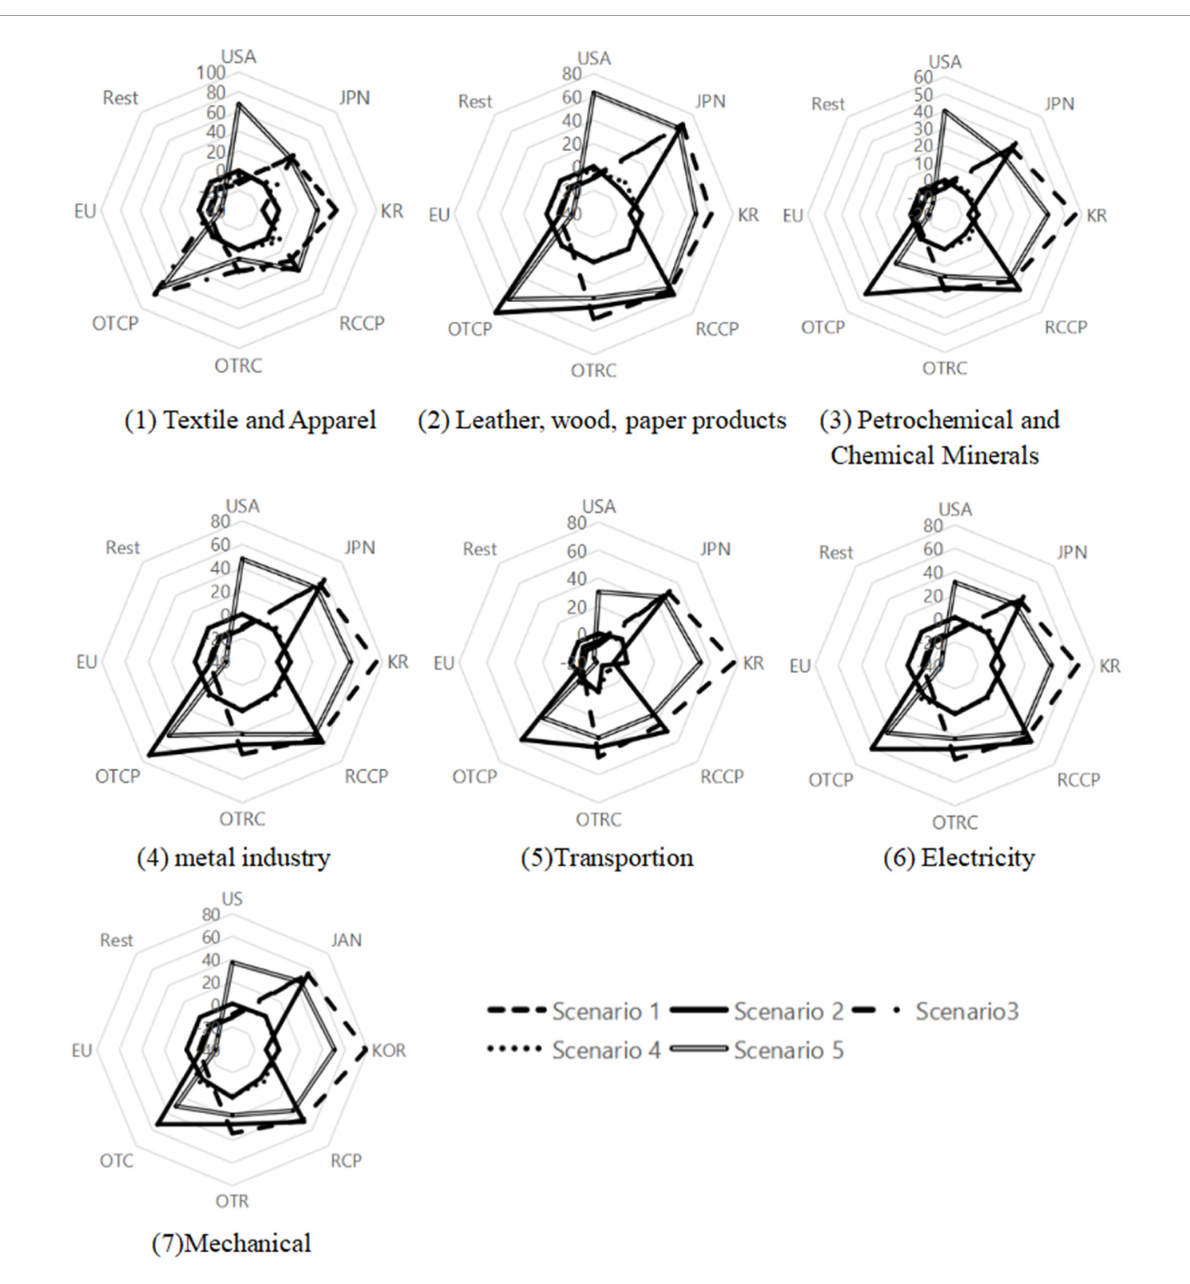
FIGURE1 Impact on exports of China’s manufacturing industries (Manufacturing industries classification is from the 10th edition of the GTAPAgg